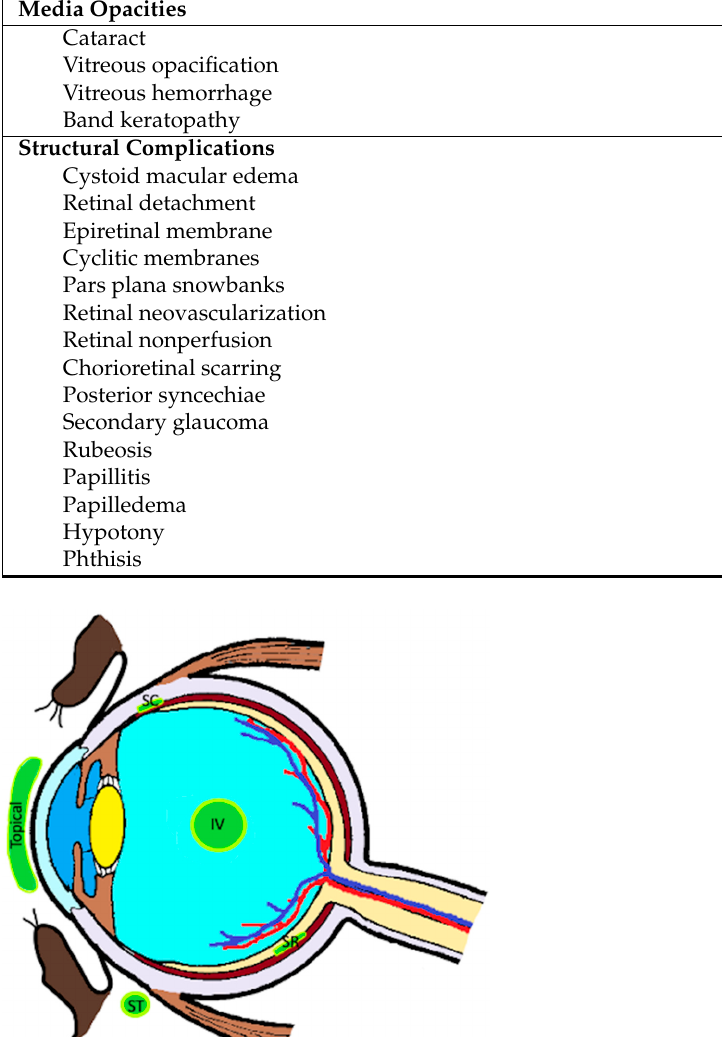
Table 1. Uveitic ocular complications requiring medical and/or surgical treatment.